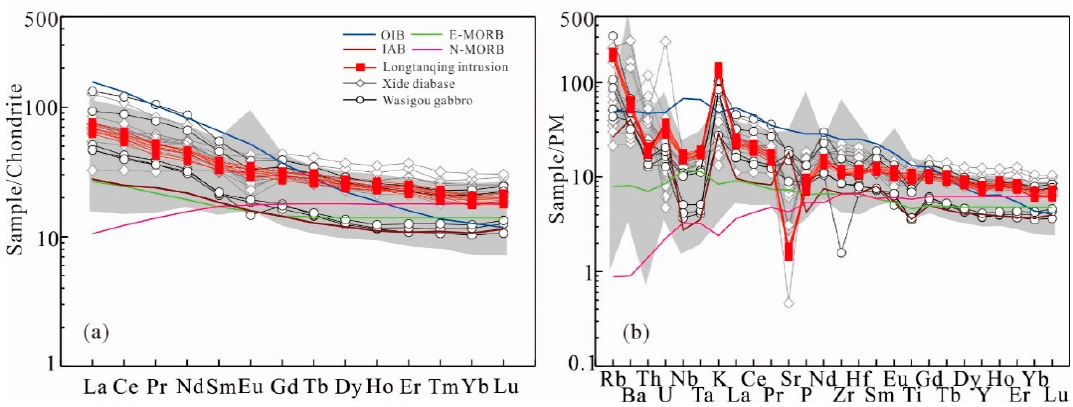
Figure 8. Chondrite-normalized REE pattern ( a ) and primitive mantle-normalized incompatible trace element spider diagrams ( b ) for the LTQ samples, Xide diabase dykes [42], and Wasigou gabbros [22], western YZB. The data for chondrite, primitive mantle values are from [80]. The average compositions of enriched mid-ocean ridge basalt (E-MORB), normal mid-ocean ridge basalt (N-MORB), ocean island basalt (OIB), and island arc basalt (IAB) are from [80] and [83]. The shaded areas outline the ranges of compositions for basic-ultrabasic rocks from the Hannan Massif of northwestern YZB with data source from [45].